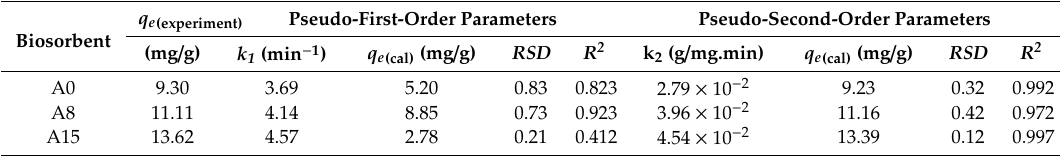
Table 4. Pseudo-first-order and pseudo-second-order kinetic model parameters for Cd 2 + ion sorption using three types of biosorbent of Aphanothece